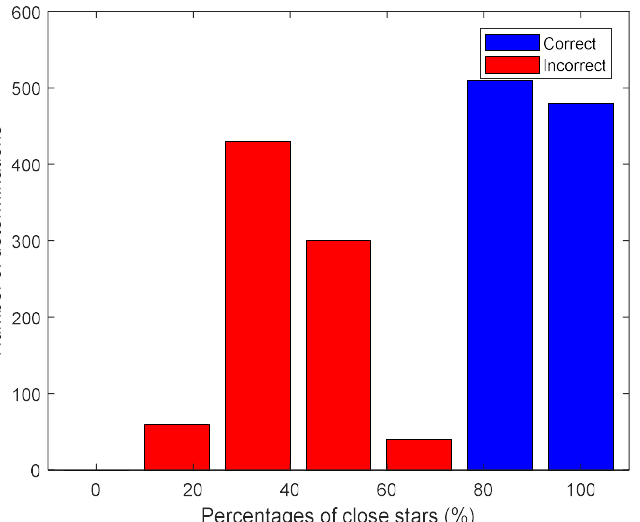
Figure 15. Separation of correct and incorrect final determinations under different percentages of close stars V rate .